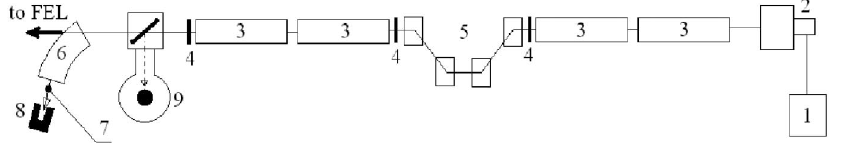
FIG. 1. The DUV-FEL accelerator layout. 1: rf gun drive laser; 2: rf gun with focusing solenoid; 3: 3 GHz linac tank; 4: focusing triplets; 5: magnetic chicane; 6: spectrometer dipole; 7: beam monitor; 8: beam dump; 9: coherent transition radiation station. The beam energy is 6 MeV after the rf gun and 72 MeV after the second linac